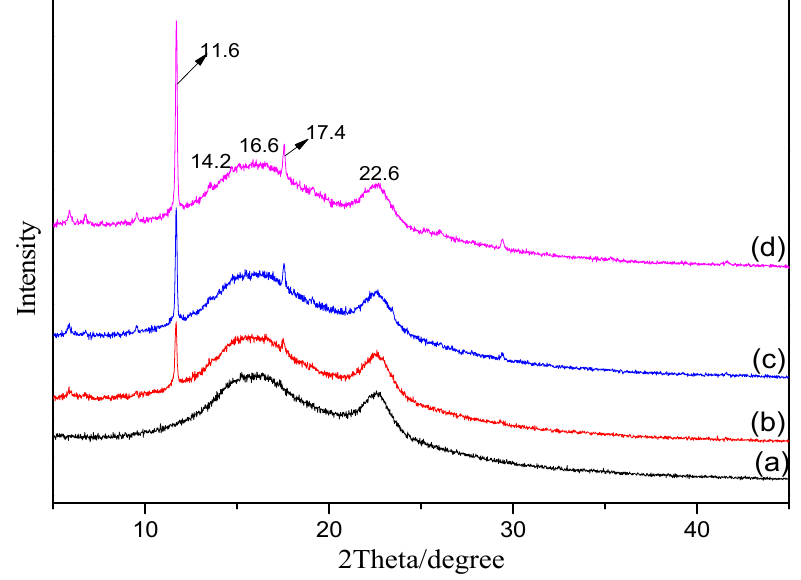
Figure 7. The XRD patterns of ( a ) pure Pebax membrane, ( b ) Pebax/Cu-BTC MMMs, ( c ) Pebax/NH 2 - Cu-BTC MMMs and ( d ) Pebax/sub-NH 2 -Cu-BTC MMMs (3 wt.% MOFs content in the MMMs).